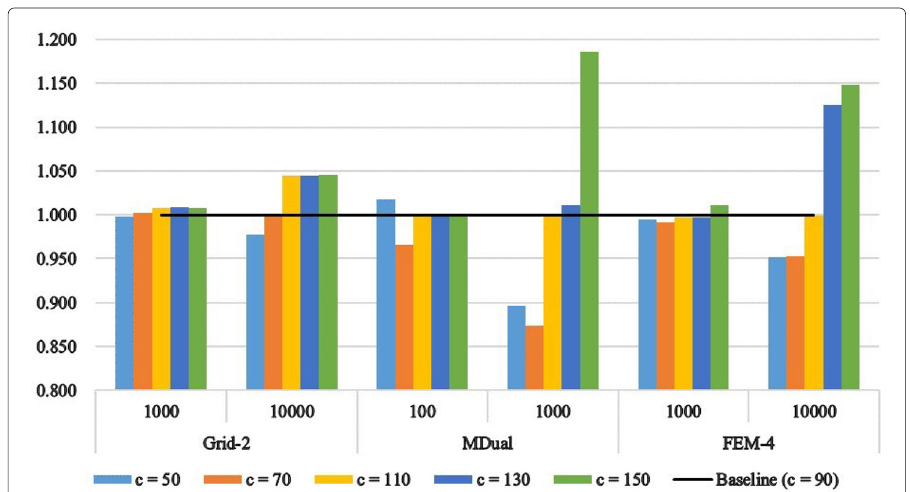
Fig. 7 The ratios of running time of other contracted parameters to that of parameter